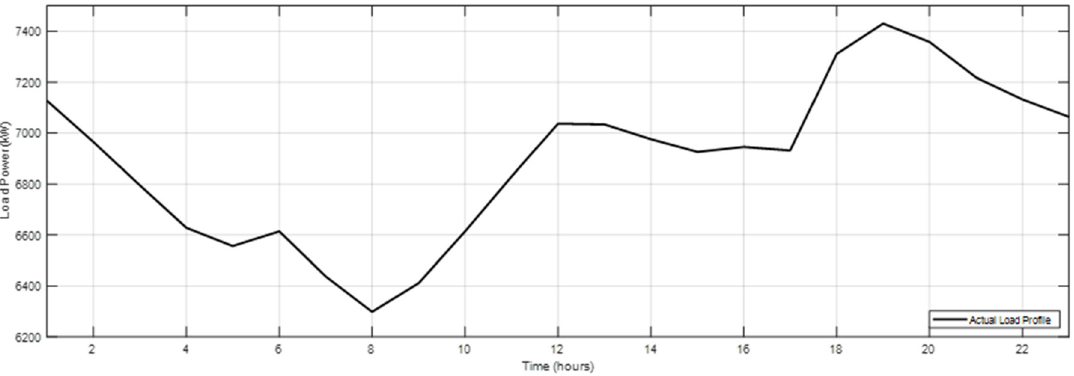
Figure 7. Minimum daily load profile in Dammam city.